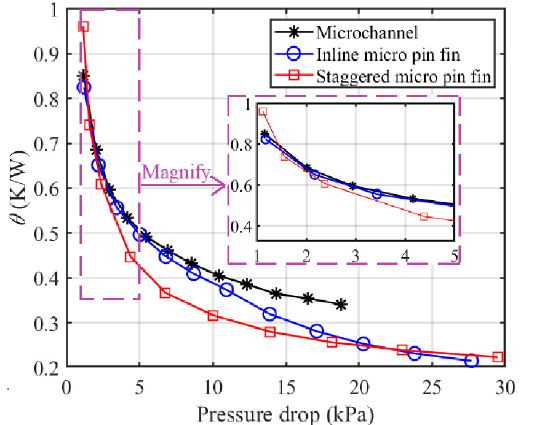
Figure 11. Variations of the average thermal resistance with the pressure drop.